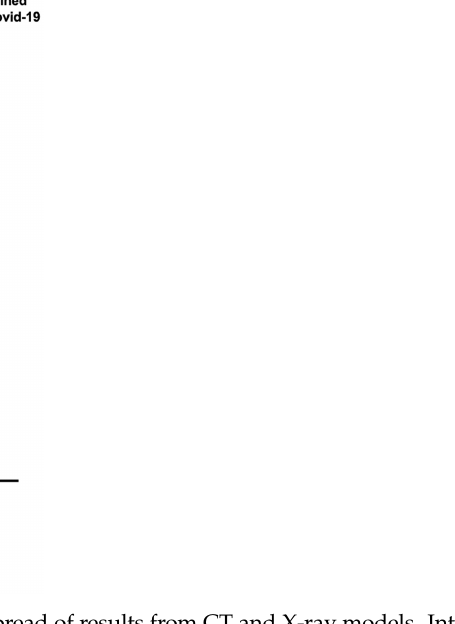
Figure 2. Box plot displaying the spread of results from CT and X-ray models. Interquartile range is demonstrated by the box, with the median value in the center. Whiskers display extremes at either